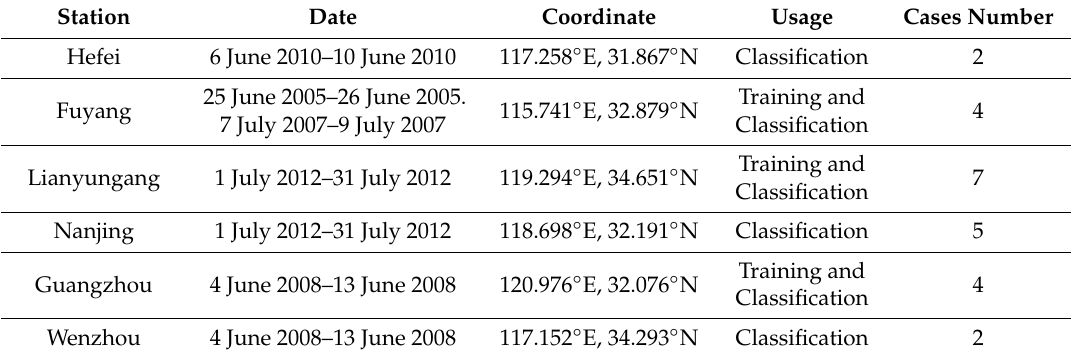
Table 1. Radar site information and data usage